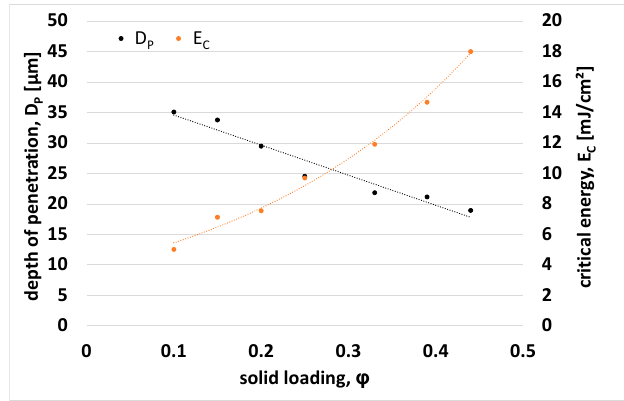
Figure 6. 𝐷 (cid:3017) and 𝐸 (cid:3004) derived from experimental data. Figure 6. D P and E C derived from experimental